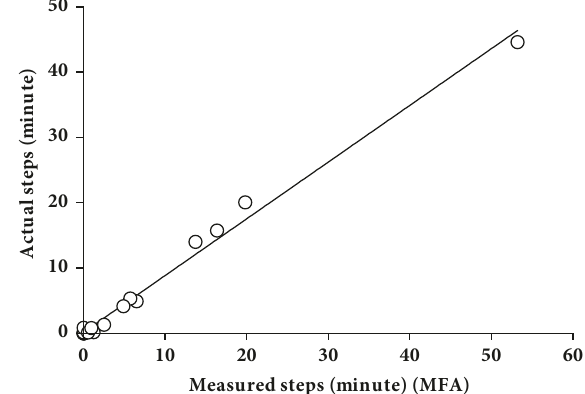
Figure 2: The chart shows a regression analysis correlating the steps per minute measured with the steps per minute actually made (gold standard). The steps were recorded by a Misfit Shine worn at the ankle (MFA). 𝑅 2 = 0.99, 𝑛 = 24